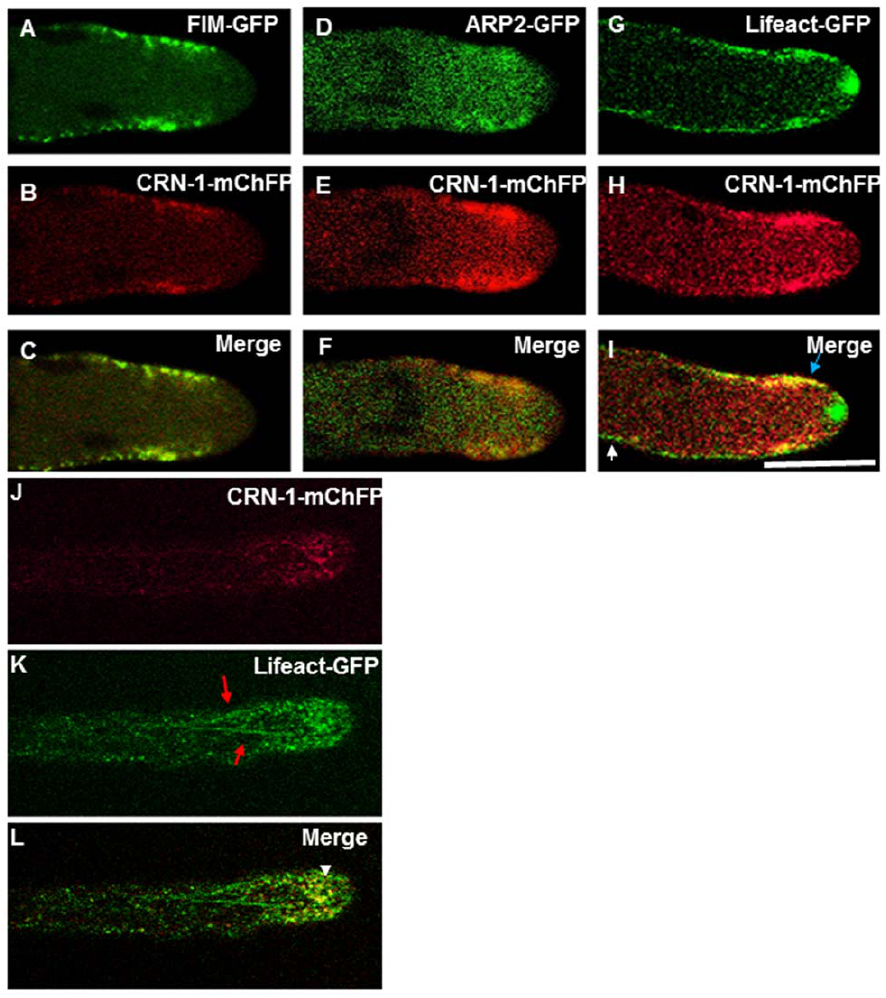
Figure 2. Co-expression of coronin with fimbrin, Arp2 and actin. (A–C) Colocalization of Fimbrin (FIM-GFP) and CRN-1-mChFP. (D–F) Colocalization of Arp2 (ARP-2-GFP) and CRN-1-mChFP. (G–I) Partial colocalization of the actin marker Lifeact-GFP and CRN-1-mChFP. (J–L) Co- expression of CRN-1-mChFP and Lifeact-GFP showing the lack of colocalization between coronin patches and actin cables. are depicted by. (L) Merge, not clear association of crn-1 patches is observed with actin filaments, arrowhead shows colocalization of actin patches with CRN-1-mChFP. The white arrow points a region where there is only labeling with Lifeact-GFP and the blue arrow show the patches where CRN-1-mChFP and Lifeact-GFP colocalized. Note the presence of actin in the Spk but not of patch related ABPs. The red arrows in (K) point the actin cables and the white arrowhead show the colocalization of actin and coronin in the patches subapical collar. Scale bar=5 m m.